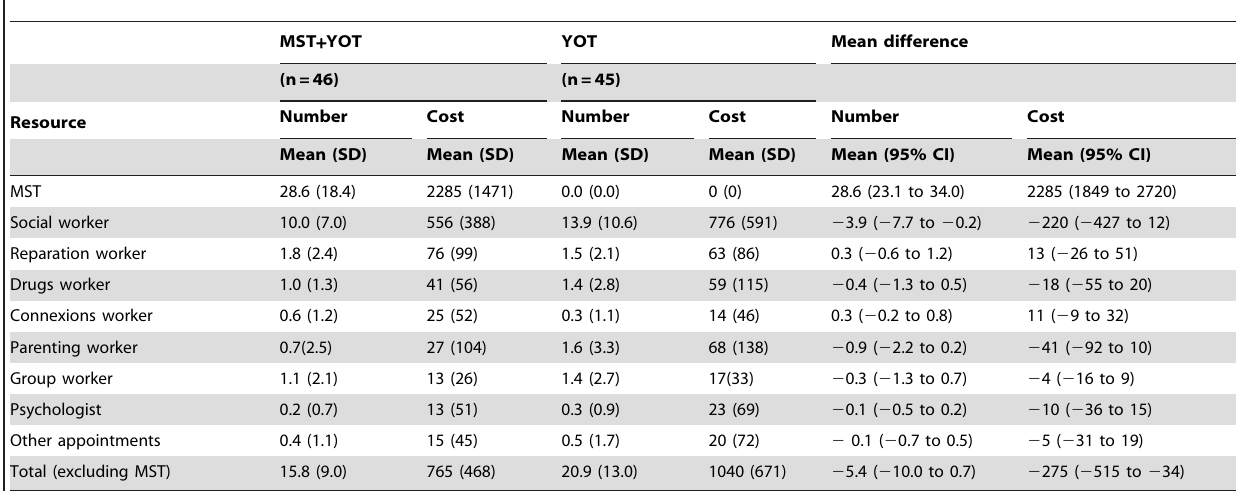
Table 2. Service use and corresponding costs (£) by young person during the intervention period.